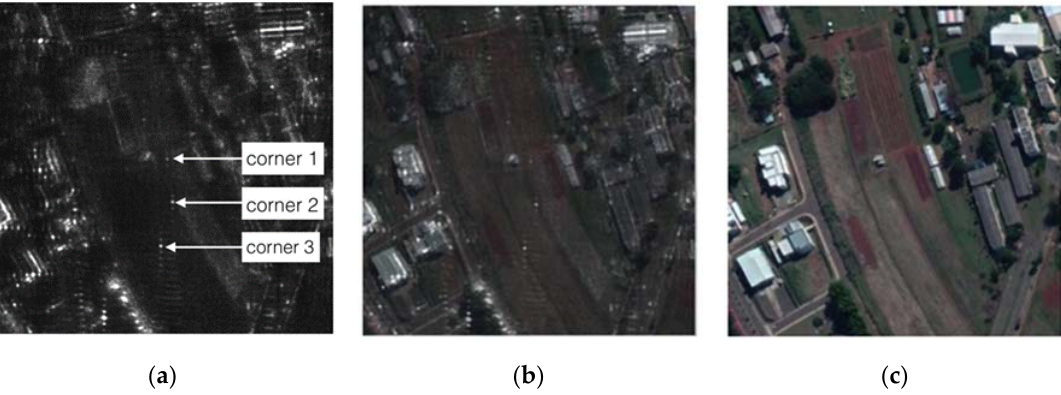
Figure 2. Test area at UNICAMP, Campinas Brazil. ( a ) Geocoded L-band SAR image of the first flight, with the indication of the position of the three corner reflectors: corner 1 in the nearest range, corner 2 in the middle range, and corner 3 in the far range. Flight track on the top of the image, from west to east (left to right), looking south (downward). ( b ) Overlay of SAR and optical images to show the target’s position. ( c ) Optical image taken on the same day.